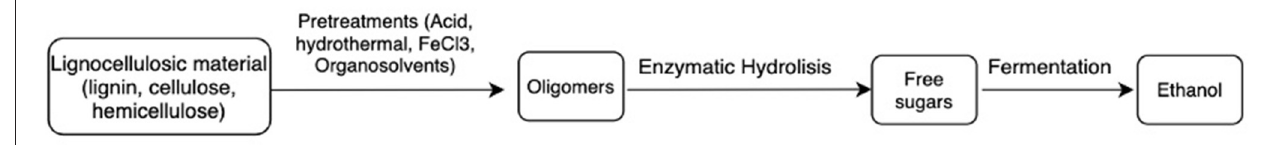
FIGURE 3 | Schematic showing the steps required to convert olive leaves into